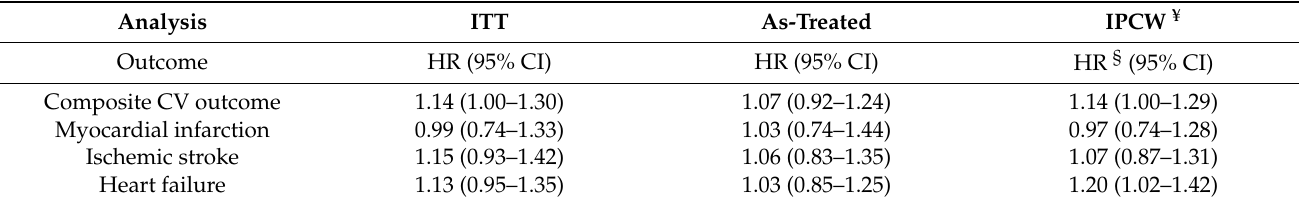
Table 3. Association between hormonotherapy (aromatase inhibitors vs tamoxifen) and study outcomes.